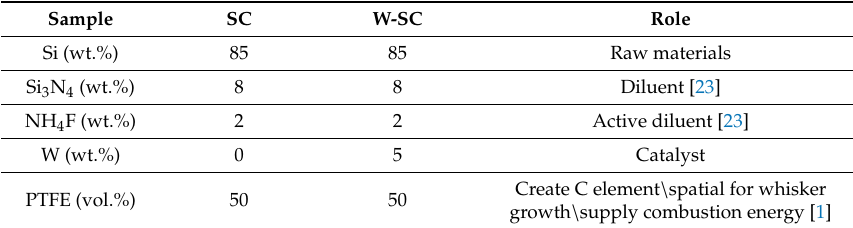
Table 1. Components of reactants. PTFE: